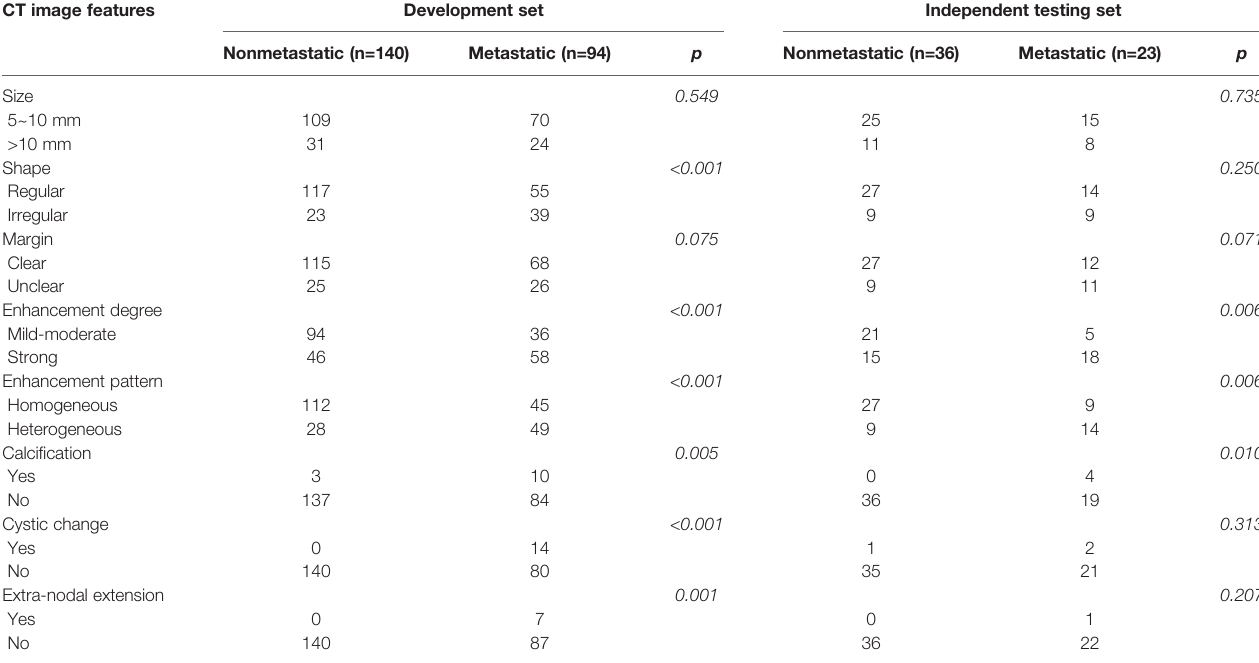
TABLE 1 | Comparison of CT image features between no-metastatic and metastatic lymph nodes. CT image